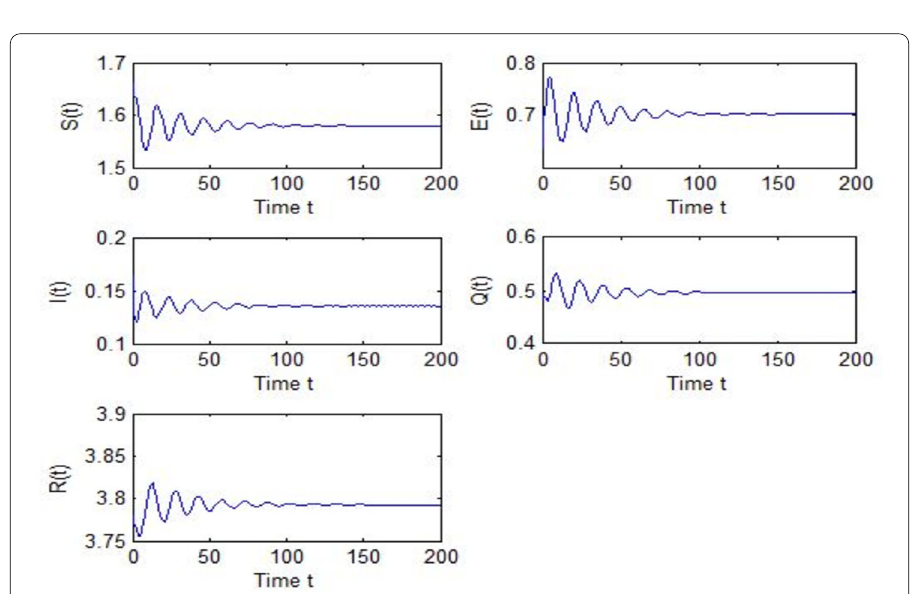
Figure 5 Evolutions of S , E , I , Q , R for τ ∗ = 2.7471 < τ ∗ 0 along with time